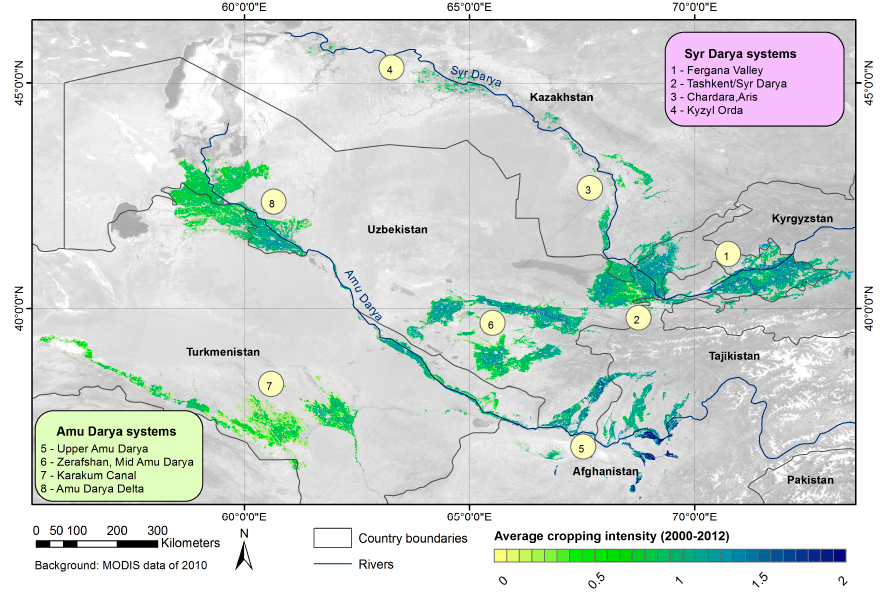
Figure 8. Irrigated cropland extent (MR-iCE = all colored pixels) and the average annual cropping intensity (MR-CI) in the ASB mapped for the observation period from 2000 to 2012.